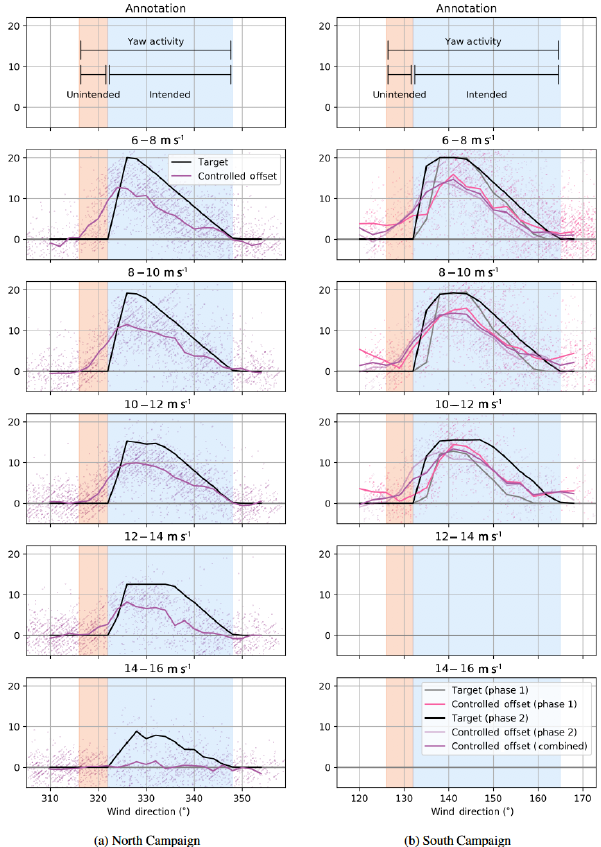
Figure 5. Comparison of targeted versus achieved offsets for the North and South Campaigns. The black lines indicate the targeted offset for a given wind speed and direction. The magenta lines show the average achieved offset (with 1min average points shown to indicate the spread in values going into that average). Colored bands are used to indicate where a yaw offset is achieved intentionally (light blue) and unintentionally (orange). The combined orange– blue region is the range of directions wherein the controller is active. The South Campaign, as discussed earlier, includes two phases of control; however, this figure indicates that the achieved offsets are similar.